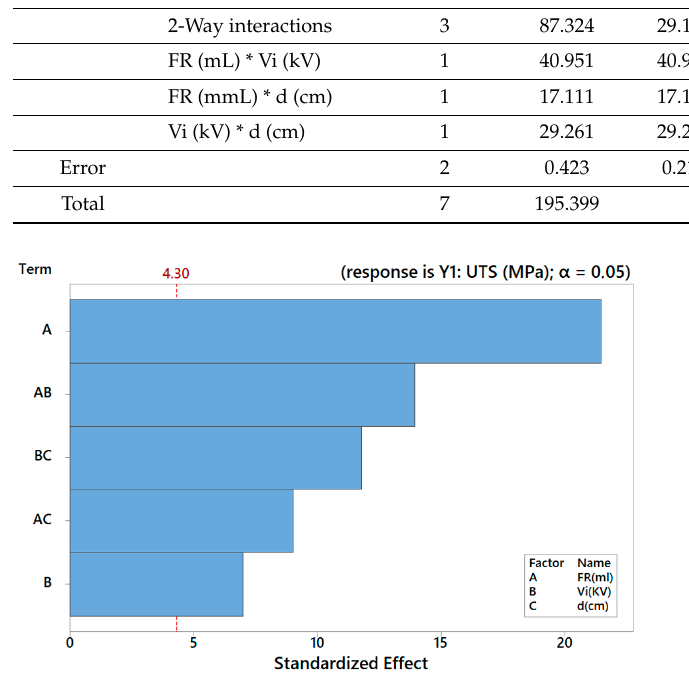
Figure 2. Pareto chart of the standardized effects for Y 1 .